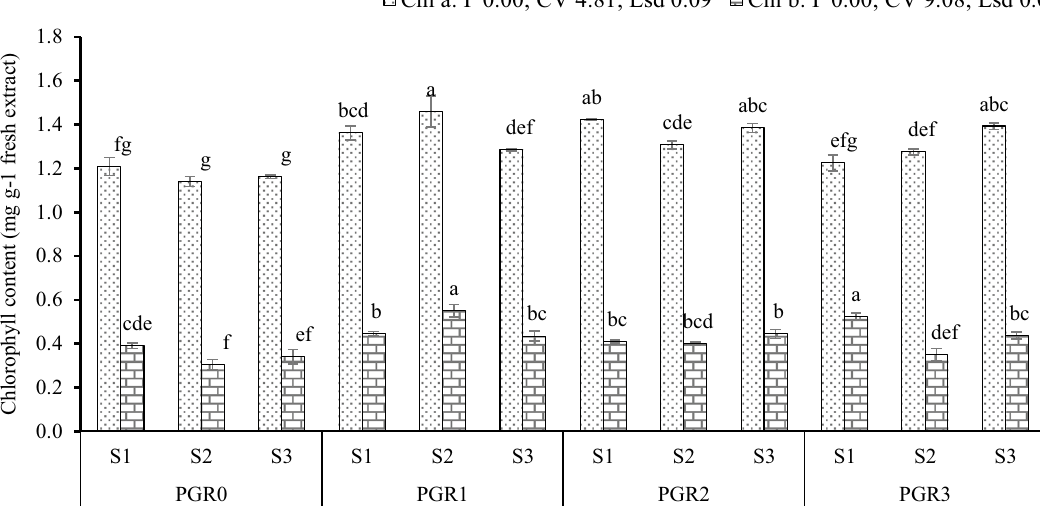
Fig. 3 Interaction effect of plant growth regulators and application stage on chlorophyll content of leaves. Chlorophylls are expressed as mg g − 1 fresh extract. Abbreviations are as follows: PGR 0 : 0, PGR 1 : 100 mgL − 1 GA 3 , PGR 2 : 100 mgL − 1 NAA and PGR 3 : 100 mgL − 1 MH (maleic hydrazide),